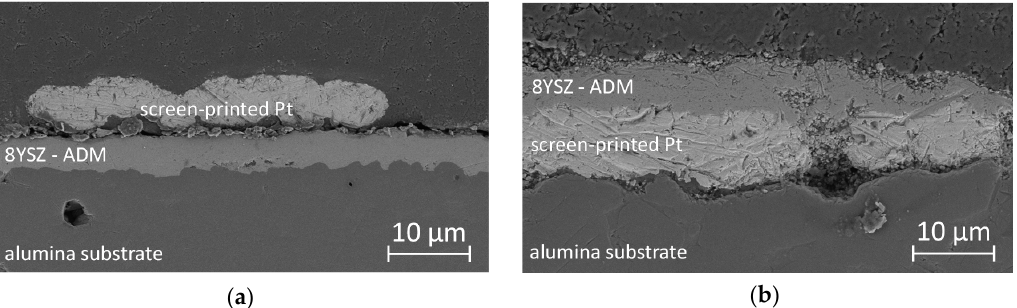
screen-printing and sintering. The location of the platinum electrodes is varied: ( a ) on top of the